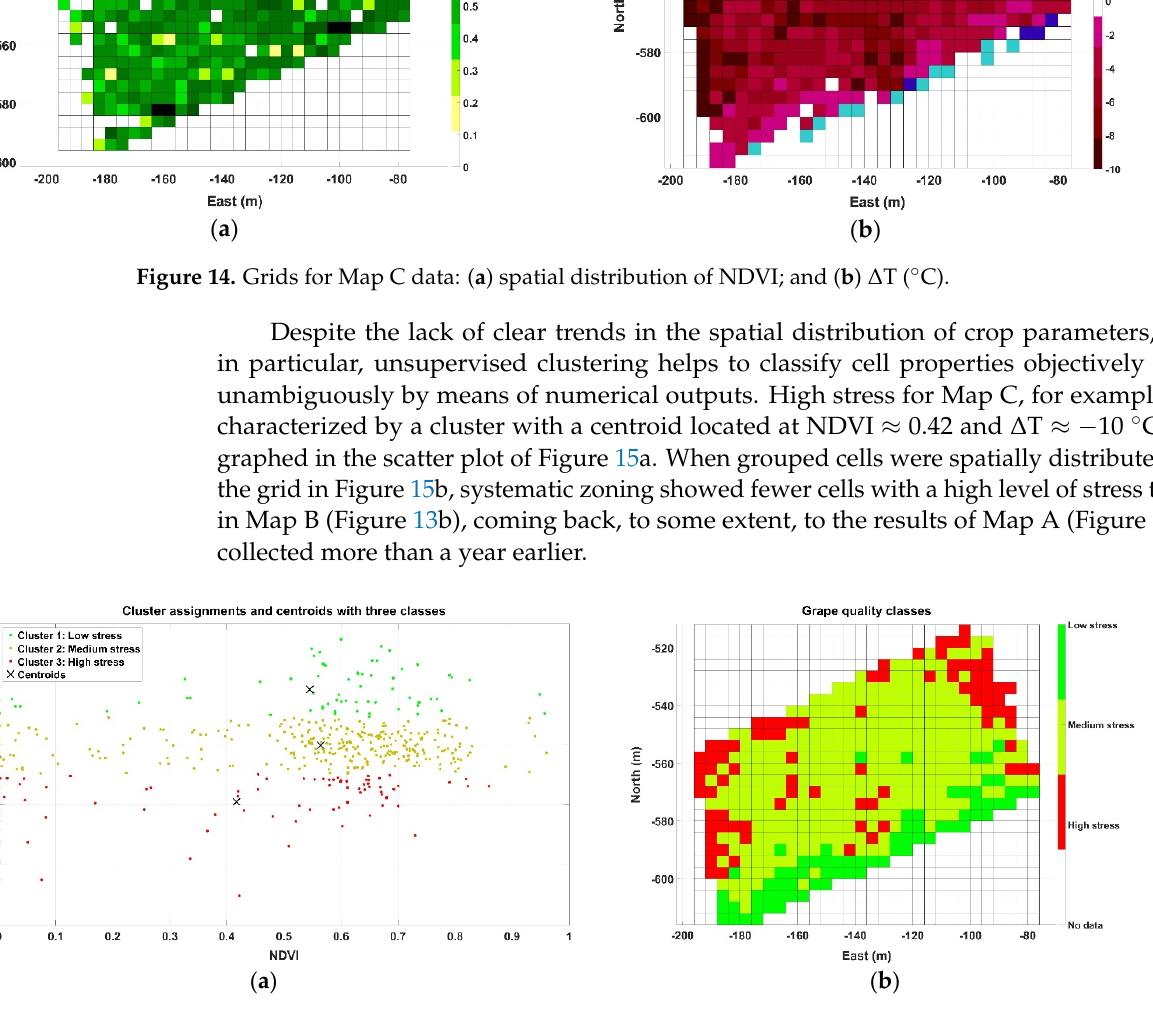
Figure 15. Clustering results and grid for Map C: ( a ) three classes (k = 3) clustering results; and ( b ) zoning.